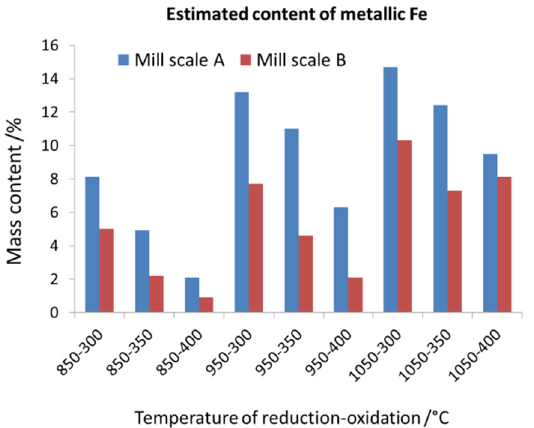
Figure 11. Estimated content of metallic iron in scale samples A and B subjected to thermal analysis.